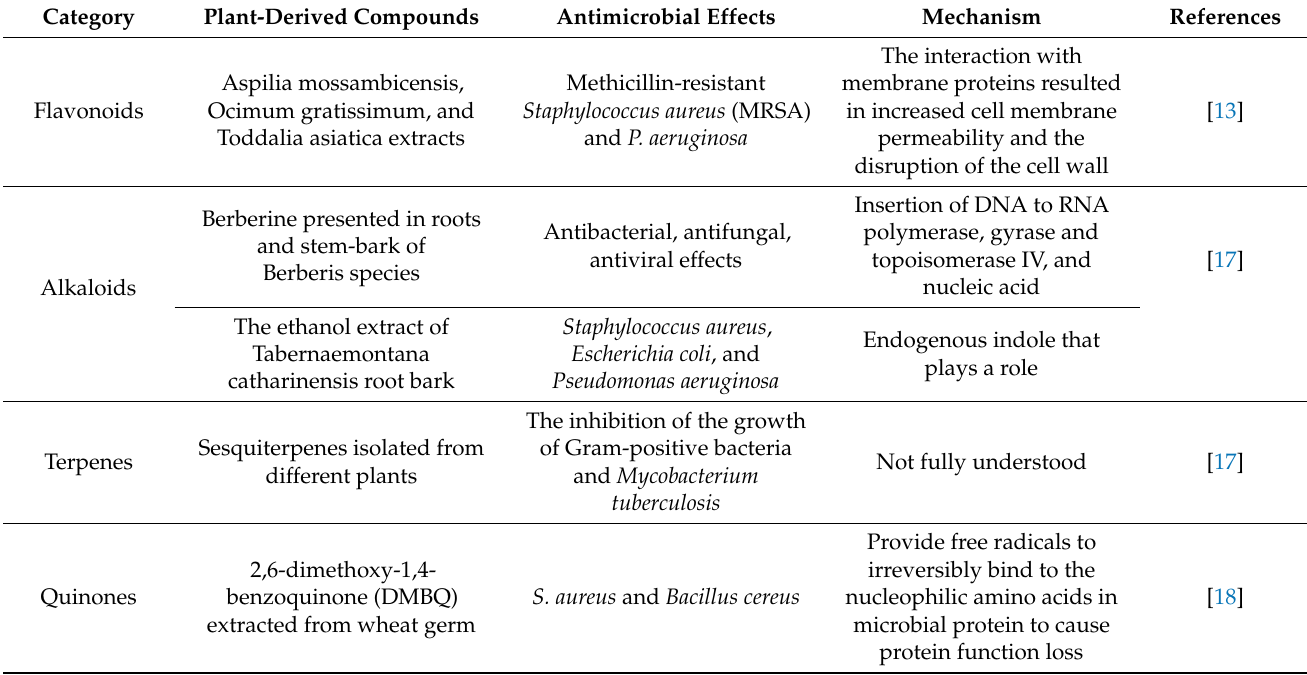
Table 1. The mechanisms of the secondary metabolites with potential antimicrobial properties. Category Plant-Derived